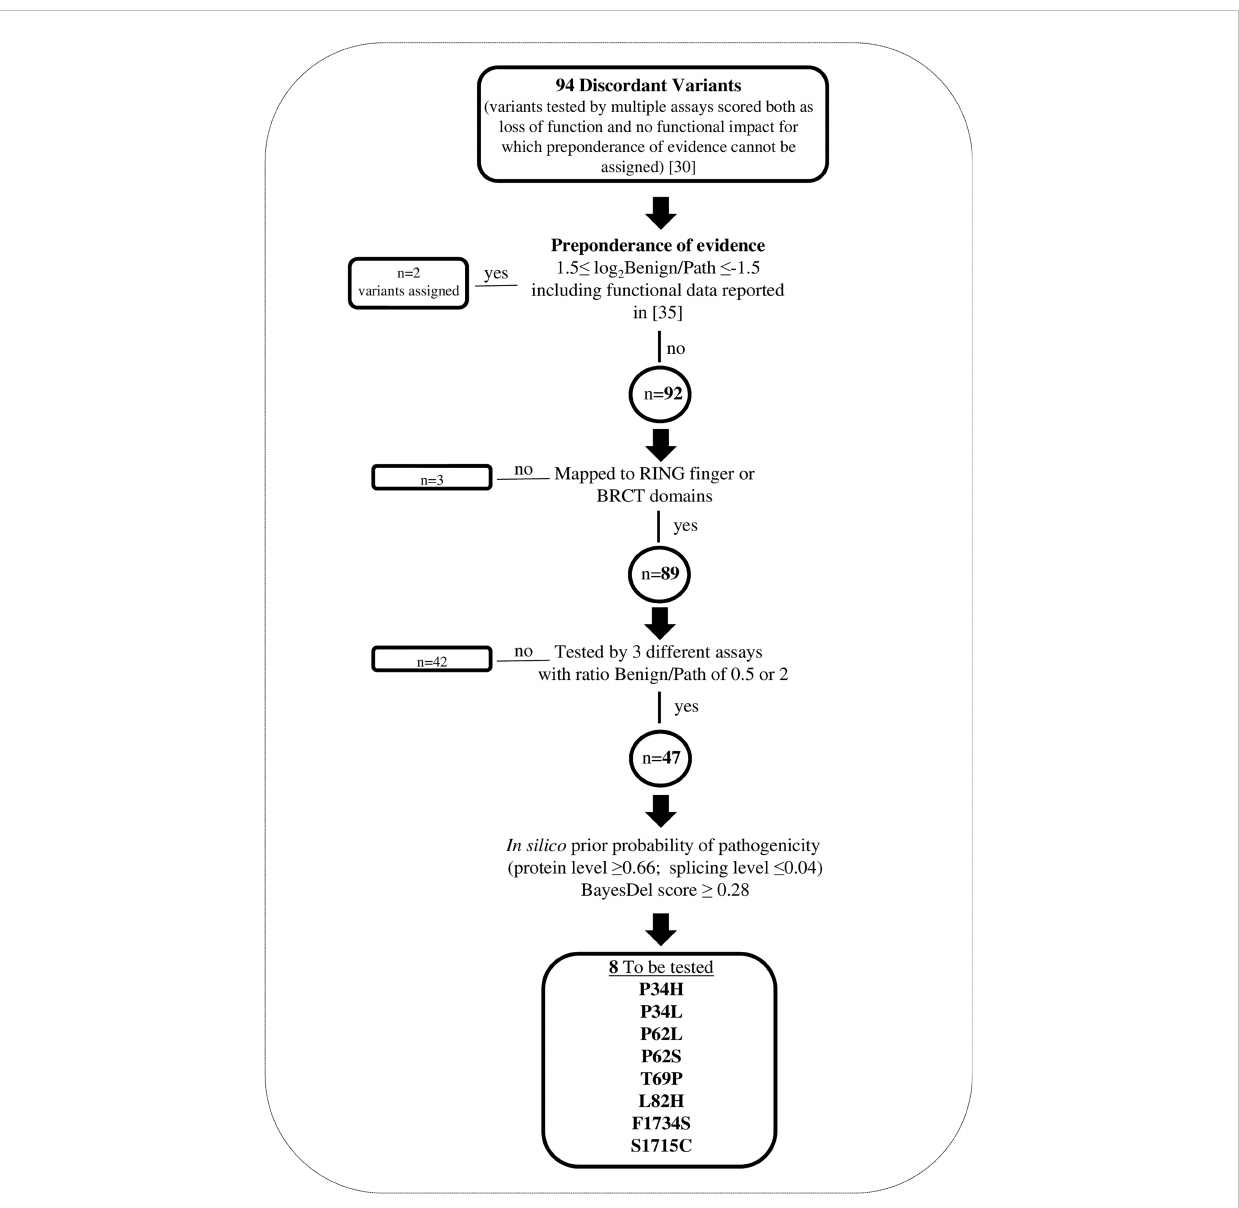
FIGURE 1 Selection of BRCA1 discordant variants tested by GFP-reassembly and M2H assays. Flow chart outlining the selection